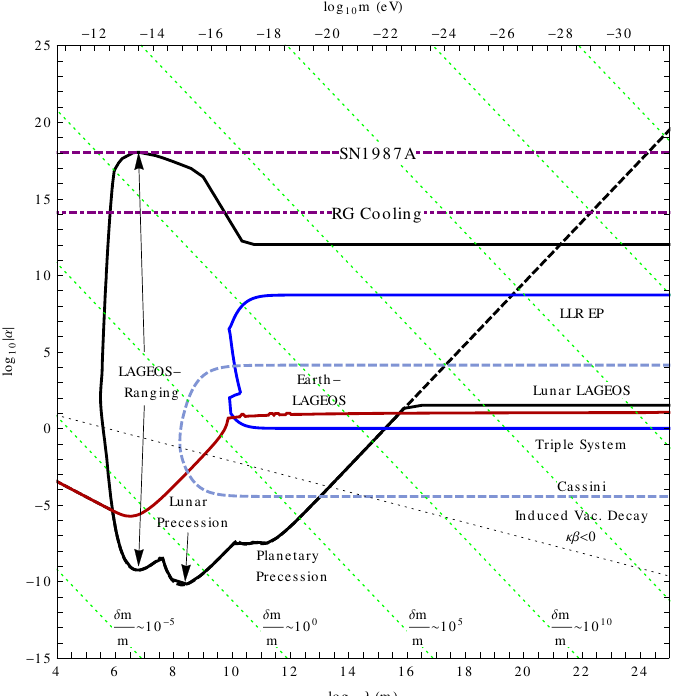
Figure 9 . Constraints on (cid:12)fth forces in the presence of natural cubic self-interactions from searches for EP-preserving forces excluding Earth-LAGEOS (black) and EP-violating forces (blue). The red contour indicates the constraint from Earth-LAGEOS [1], which is unbounded above as explained in the text, thereby closing all gaps in other experiments. Searches for EP-preserving forces shown include measurements made using the LAGEOS satellite [1, 33, 34], and the anomalous precession of the moon, Mercury and Mars [1, 35, 36]. The dashed black line shows the bounds in the absence of screening, while the solid contour shows the bounds with screening. The search for light de(cid:13)ection by the Cassini mission [17] is shown by a dashed light blue line. Searches for EP-violating forces shown include LLR-EP [38] and the stellar triple system PSR J0337 (cid:0) 1715 [37]. These would not be present in the absence of screening. The purple dashed and dot-dashed lines indicate constraints from the cooling of SN1987A and Red Giants respectively [39{41]. The dotted black line shows the constraint for (cid:20)(cid:12) (cid:160) 0 where vacuum decay would be induced in Neutron Stars. The dotted green contours indicate the level of tuning of the mass required as a function of (cid:11)